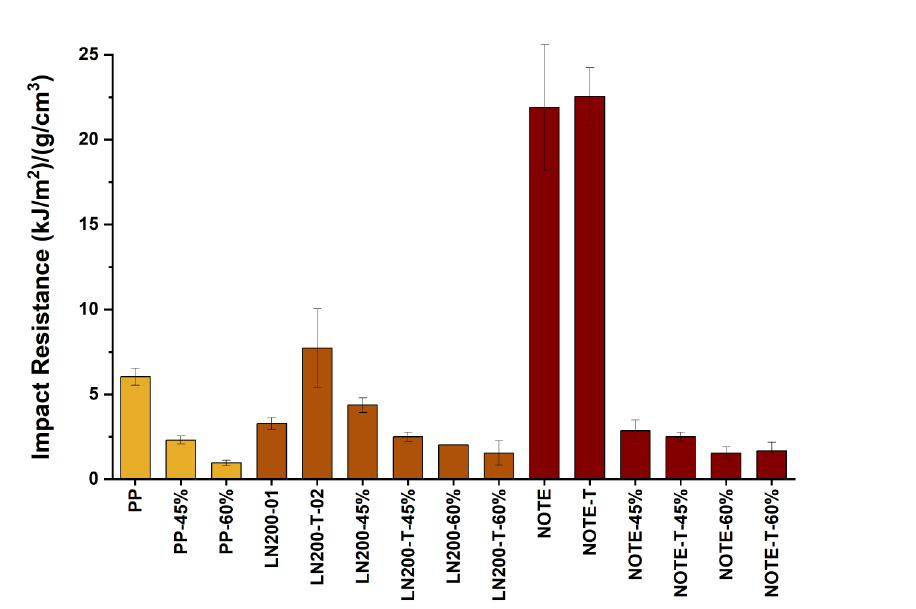
Figure 9: Impact specific